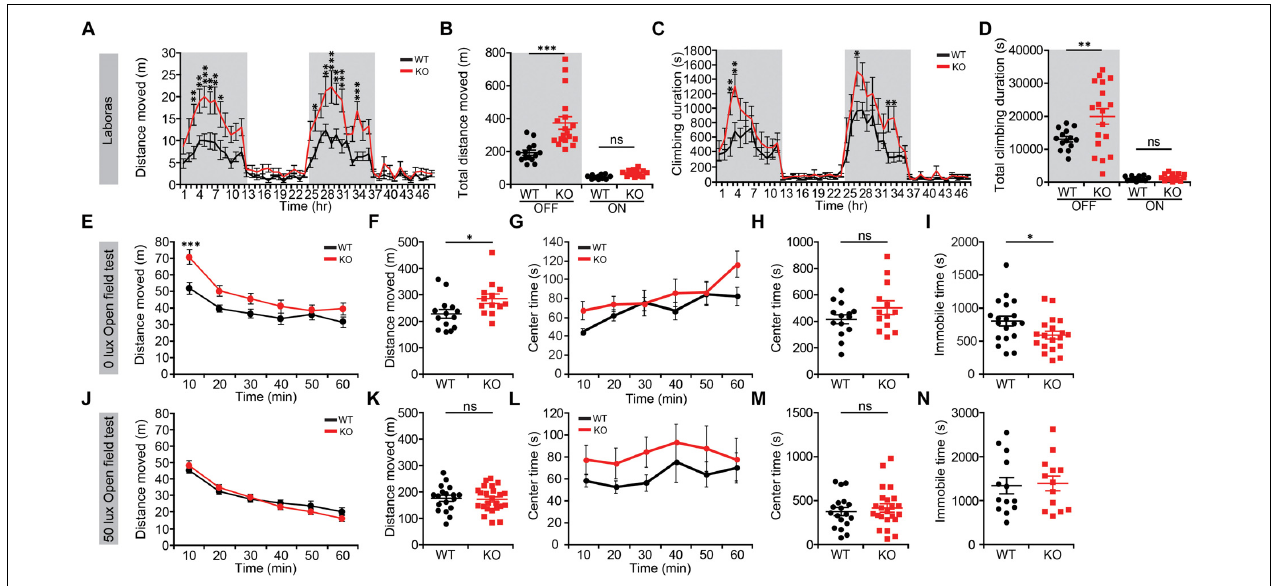
FIGURE 1 | Lrrc4c − / − mice display hyperactivity in a familiar environment. (A,B) Increased locomotor activity of Lrrc4c − / − mice (2–5 months; male) in Laboras cages (familiar environment), as shown by distance moved during the last two consecutive days. n = 14 mice (WT), n = 18 (KO), ∗ p < 0.05, ∗∗ p < 0.01, ∗∗∗ p < 0.001, two-way repeated-measures ANOVA with Holm-Sidak multiple comparison test [ (A) interaction, F ( 47 , 1410 ) = 3.206, p < 0.0001; time, F ( 47 , 1410 ) = 24.99, p < 0.0001; genotype, F ( 1 , 30 ) = 18.23, p = 0.0002; 3 h, p = 0.0072; 4 h, p = 0.0041; 5 h, p = 0.0007; 6 h, p = 0.0055; 7 h, p = 0.0016; 8 h, p = 0.0169; 26 h, p = 0.0483; 28 h, p = 0.0055; 29: p < 0.0001; 30 h, p = 0.0023; 31 h, p = 0.0003; 34 h, p = 0.0002; (B) interaction, F ( 1 , 60 ) = 11.36, p = 0.0013; genotype, F ( 1 , 60 ) = 19.99, p < 0.001; time, F ( 1 , 60 ) = 96.26, p < 0.001; OFF, p = 0.4393, ON, p < 0.001]. (C,D) Increased climbing of Lrrc4c − / − mice (2–5 months; male) in Laboras cages, as shown by climbing duration. n = 14 mice (WT), n = 18 (KO), ∗ p < 0.05, ∗∗ p < 0.01, two-way repeated-measures ANOVA with Holm-Sidak multiple comparison test [ (C) interaction, F ( 47 , 1410 ) = 1.859, p = 0.0004; time, F ( 47 , 1410 ) = 27.58, p < 0.0001; genotype, F ( 1 , 30 ) = 6.135, p = 0.019; 3 h, p = 0.0056; 4 h, p = 0.0018; 27 h, p = 0.0163; 33 h, p = 0.0239; 34 h, p = 0.0157; (D) interaction, F ( 1 , 60 ) = 5.357, p = 0.0241; genotype, F ( 1 , 60 ) = 6.568, p = 0.0129; time, F ( 1 , 60 ) = 116.3, p < 0.001; OFF, p = 0.8612, ON, p = 0.0021]. (E–I) Modestly increased locomotor activity of Lrrc4c − / − mice (2–5 months; male) in the open-field test at 0 lux, as shown by distance moved. Note that the center time, a measure of anxiety-like behavior, is not altered and that immobile time is decreased in Lrrc4c − / − mice, in line with the hyperactivity in Lrrc4c − / − mice. n = 14 (WT), n = 13 (KO), ∗ p < 0.05, ∗∗∗ p < 0.001, ns, not significant, two-way repeated-measures ANOVA with Holm-Sidak multiple comparison test, Mann–Whitney test (F) and Student’s t -test (H) [ (E) interaction, F ( 5 , 125 ) = 4.211, p = 0.0014; genotype, F ( 5 , 125 ) = 5.288, p = 0.0301; time, F ( 1 , 25 ) = 5.288, p < 0.001; 10 min, p = 0.0006; (F) U = 41; p = 0.0145; (G) F ( 5 , 200 ) = 2.606, p = 0.0262; genotype, F ( 1 , 40 ) = 0.0756, p = 0.7848; time, F ( 5 , 200 ) = 127.5, p < 0.001; (H) t ( 40 ) = 0.2749; p = 0.7848; (I) t ( 36 ) = 2.216; p = 0.0331]. (J–N) Normal locomotor activity of Lrrc4c − / − mice (2–5 months; male) in the open-field test at 50 lux, as shown by distance moved. Note that the center time and immobile time are not altered. n = 18 (WT), n = 24 (KO), ∗ p < 0.05, ∗∗ p < 0.01, ns, not significant, two-way repeated-measures ANOVA with Holm-Sidak multiple comparison test, Student’s t -test [ (J) F ( 5 , 125 ) = 1.4, p = 0.2287; genotype, F ( 1 , 25 ) = 2.409, p = 0.1332; time, F ( 5 , 125 ) = 6.864, p < 0.001; (K) t ( 25 ) = 1.434; p = 0.1639; (L) F ( 5 , 200 ) = 0.315, p = 0.9036; genotype, F ( 1 , 40 ) = 1.127, p = 0.2948; time, F ( 5 , 200 ) = 1.348, p = 0.2457; (M) t ( 39 ) = 0.6046; p = 0.5489; (N) t ( 24 ) = 0.2570; p =